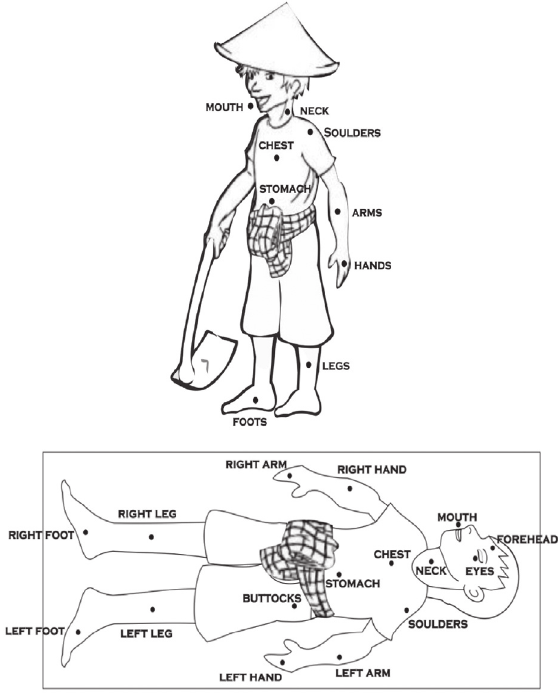
Figure 1. PMR from Bernstein and Borkovec for tension release in 16 major muscle groups. PMR, progressive muscle